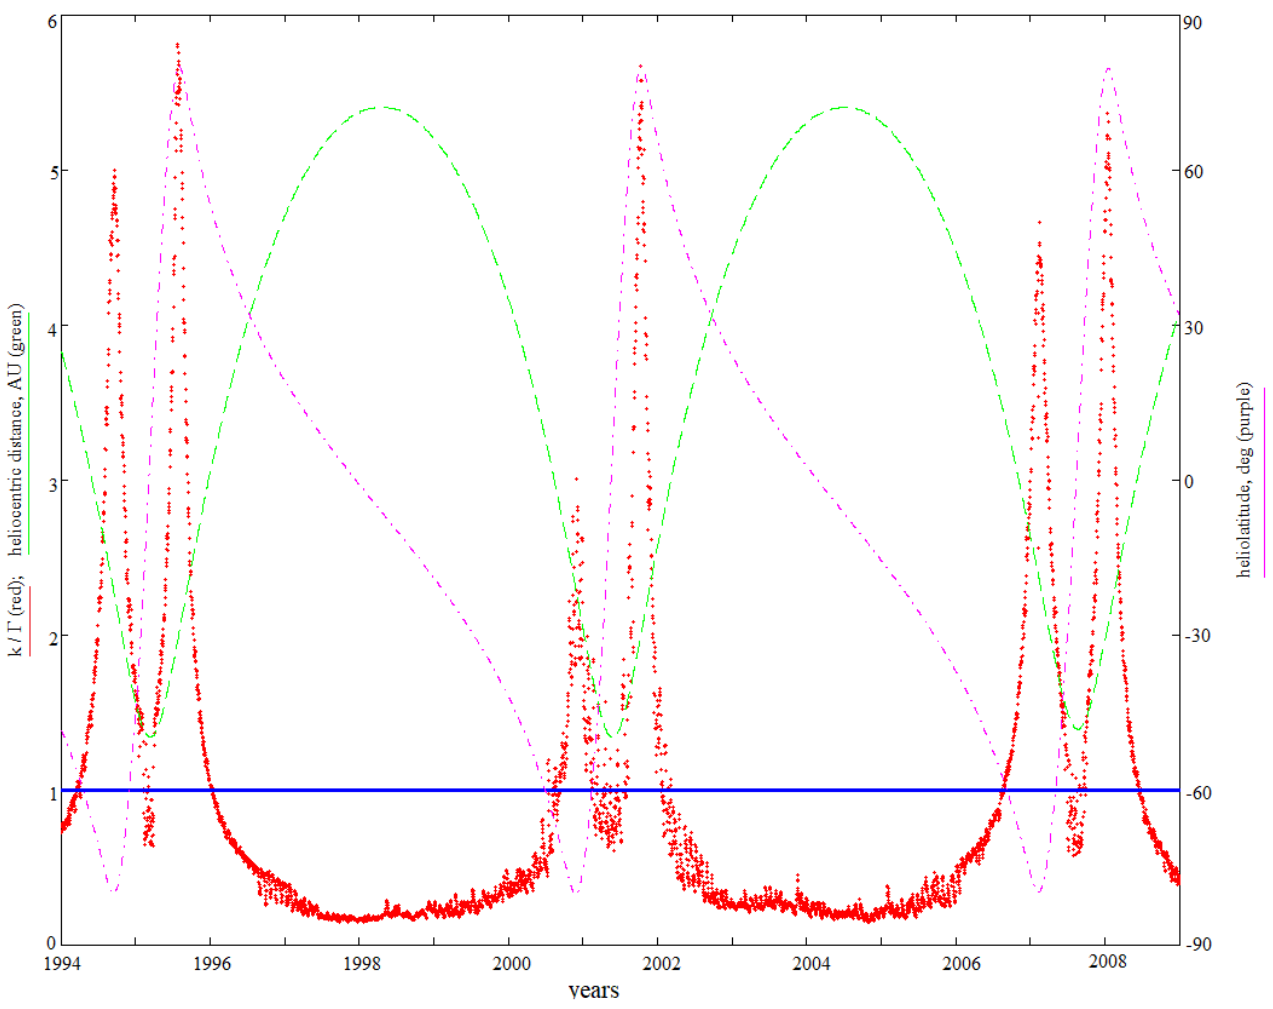
Figure 5. Ratio of the unipolar coefficient k and the geometric factor Γ for the years 1994–2008 (left vertical axis). Daily averaged Ulysses data. Horizontal blue line corresponds to k/ Γ = 1. Green dashed line corresponds to heliocentric distance in AU (left vertical axis). Purple dashed line is Ulysses heliolatitude in degrees (right vertical axis). Maximum values of k/ Γ are obtained during Ulysses passes in the polar heliosphere.